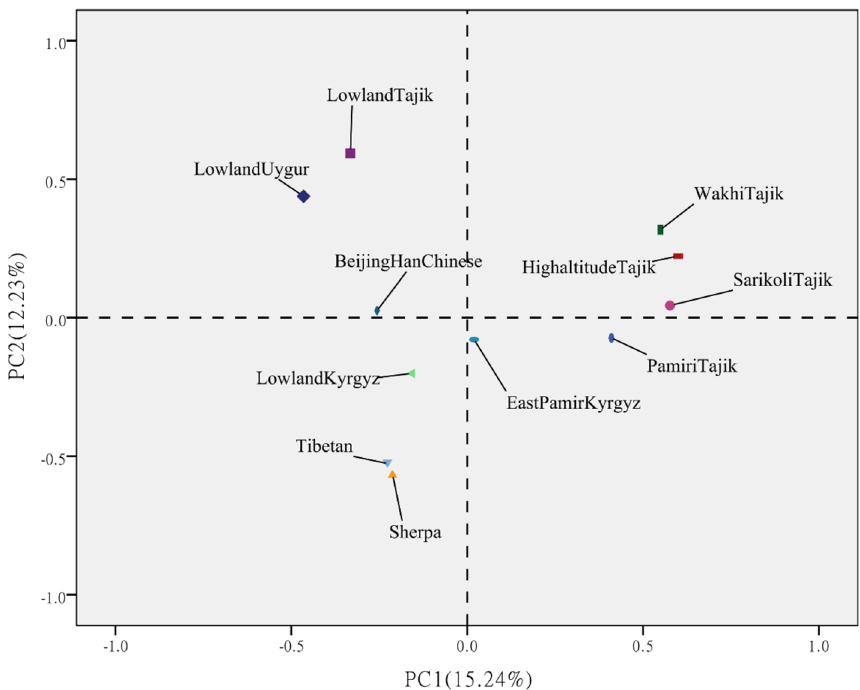
Figure 3. PCA of populations from HA-Tajiks and other ten populations. PC map of populations based on mtDNA haplogroup frequencies (Table S2).